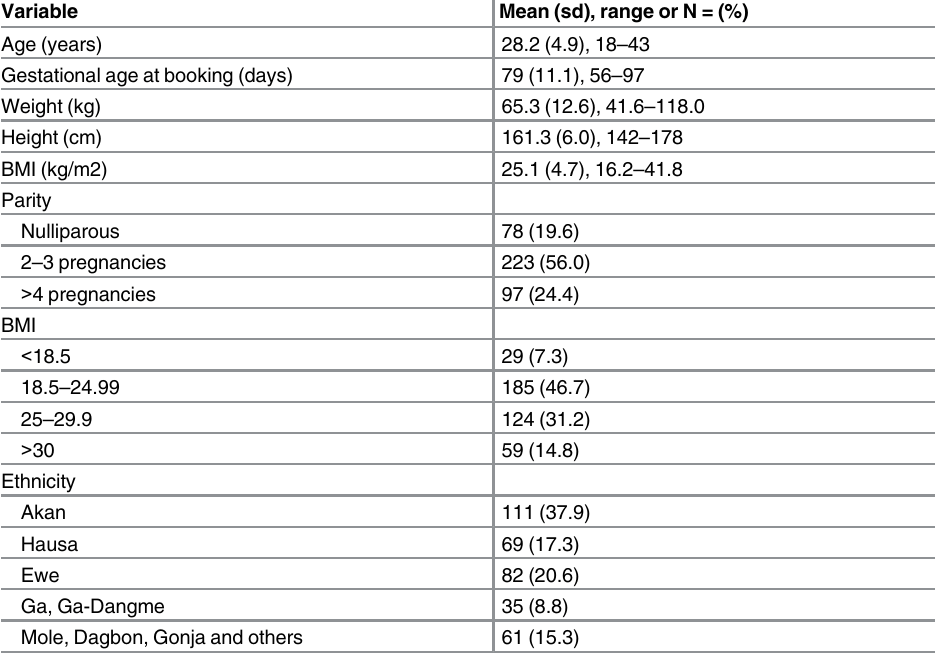
Table 1. Baseline characteristics of participating pregnant women from Accra, Ghana (n = 398).